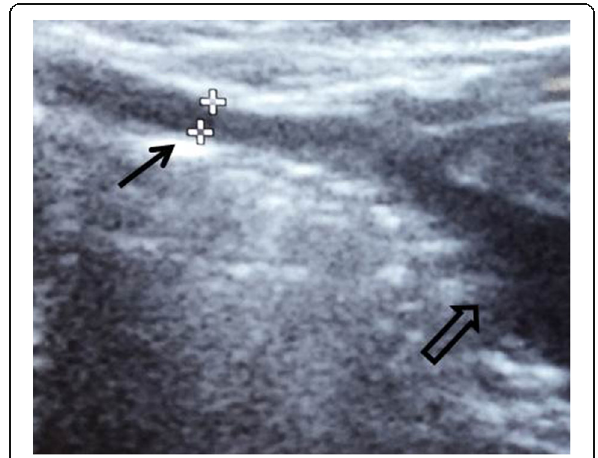
Fig. 3 Whole mount view. There were multiple fragments of fibrotic tissue and a piece of small bowel mucosa (original magnification